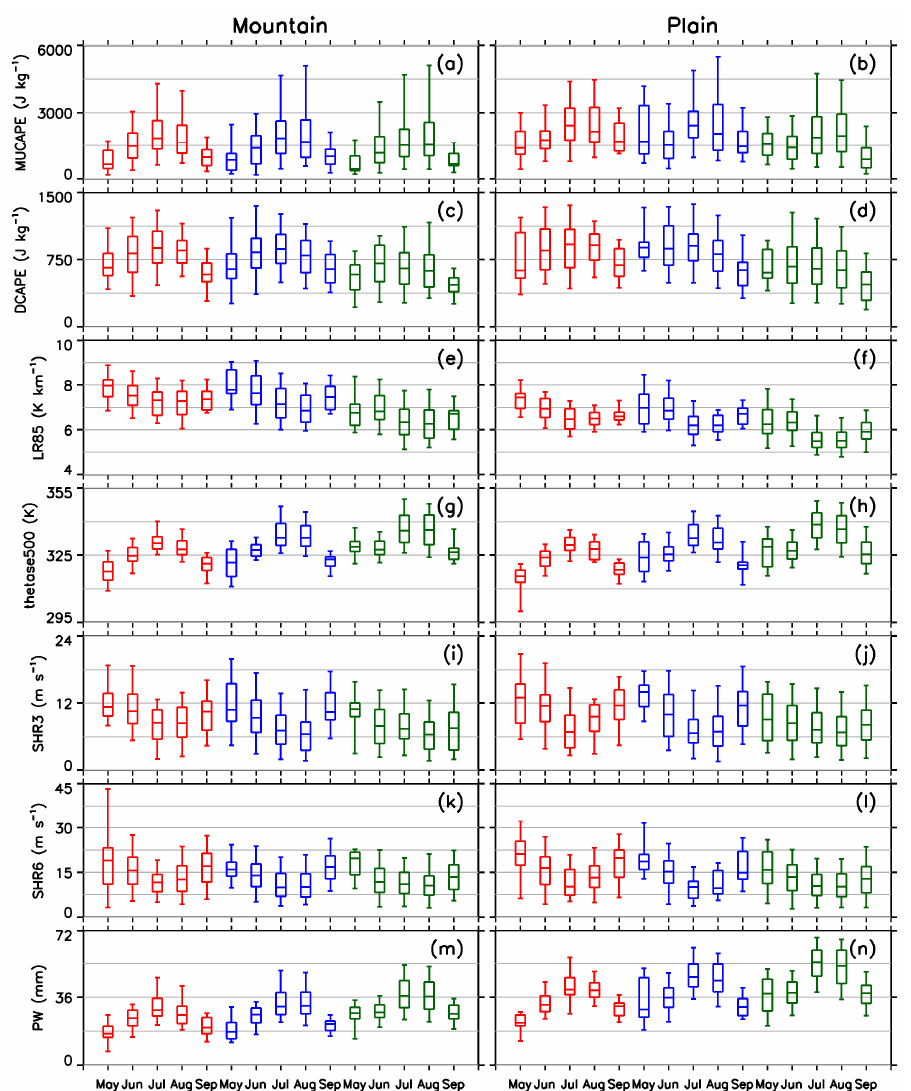
Figure 10. Box-and-whisker plots of the environmental parameters associated with three types of severe convective events in different months over the ( a , c , e , g , i , k , m ) mountains and ( b , d , f , h , j , l , n ) plains. Hail, THW, SDHR events are indicated in red, blue, and green, respectively. Parameters include: ( a , b ) MUCAPE, ( c , d ) DCAPE, ( e , f ) LR85, ( g , h ) thetase500, ( i , j ) SHR3, ( k , l ) SHR6, and ( m , n )